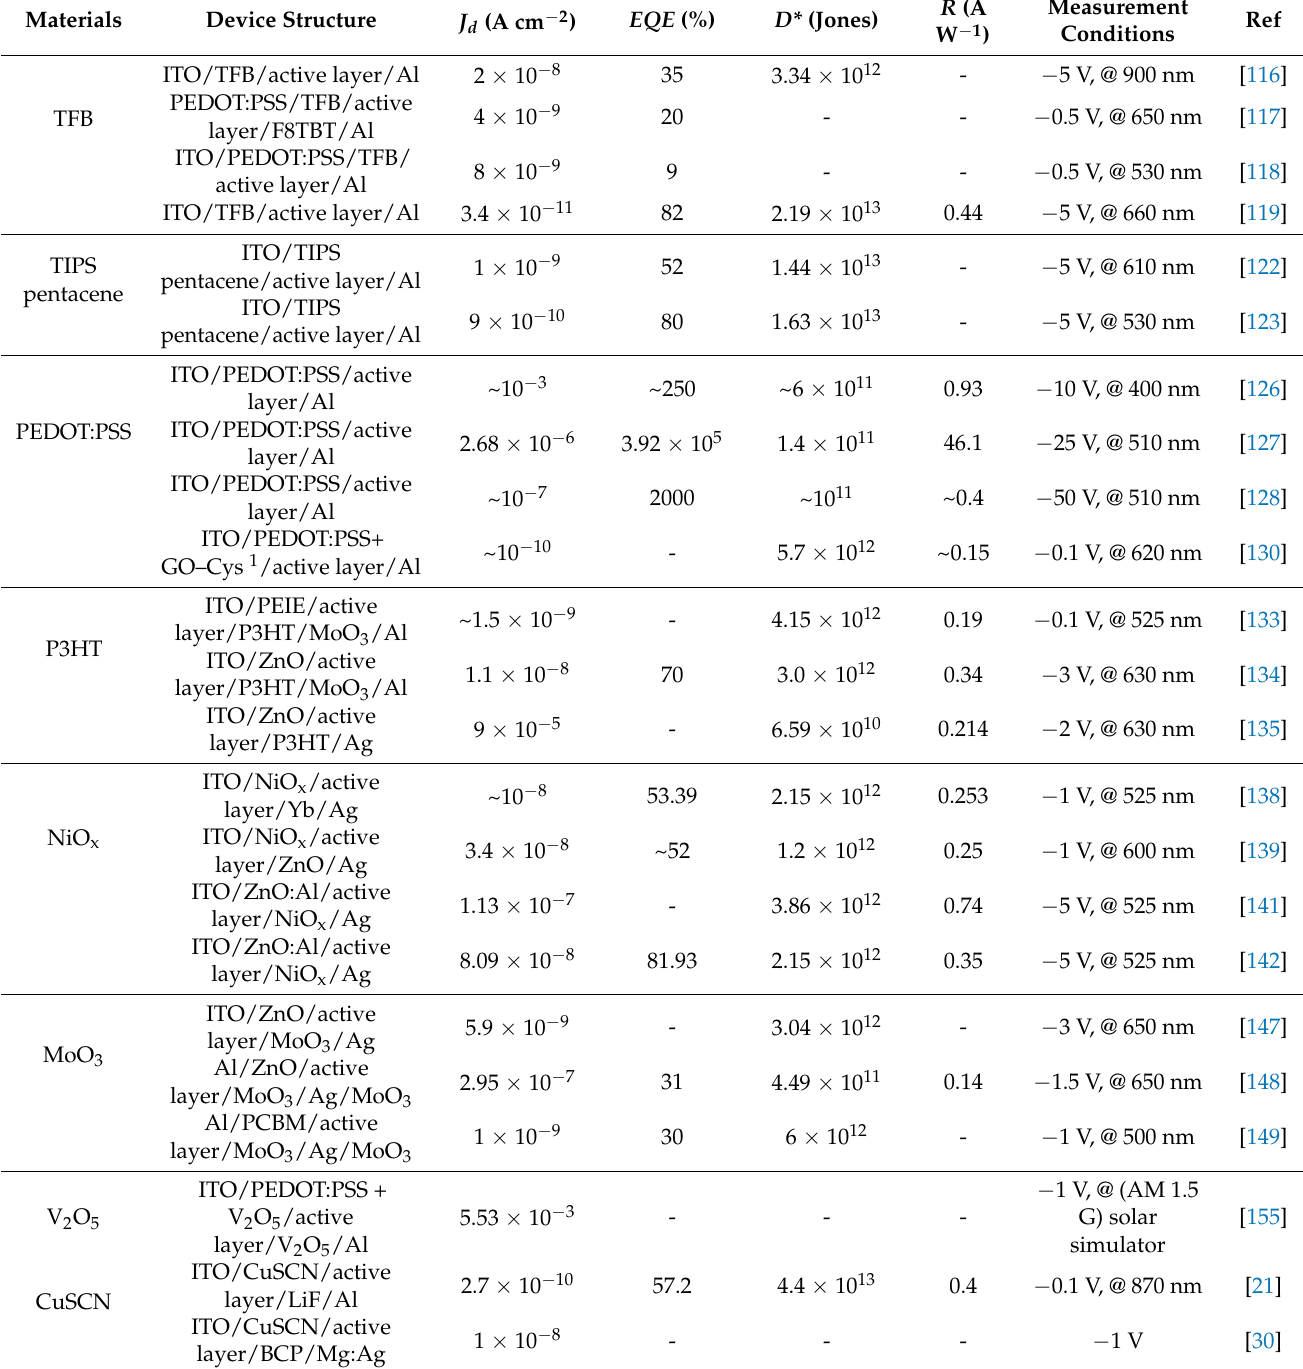
Table 2. Survey of the main characteristics of OPD-employing materials such as